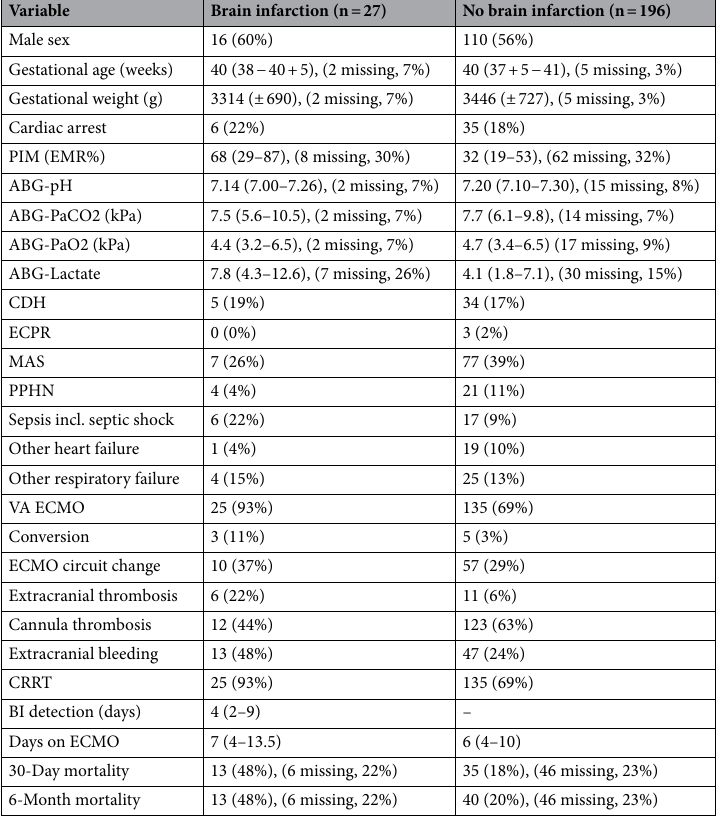
Table 1. Data comparison stratified by brain infarction status. Values are expressed as median (interquartile range), numbers (proportion) or mean (standard deviation). ABG = arterial blood gas, BI = brain infarction, CDH = congenital diaphragmatic hernia, CRRT = continuous renal replacement therapy, ECMO = extracorporeal membrane oxygenation, ECPR = extracorporeal cardiopulmonary resuscitation, EMR% = estimated mortality rate in percent, MAS = meconium aspiration syndrome, PIM = pediatric index of mortality, PPHN = persistent pulmonary hypertension in the newborn, VA =